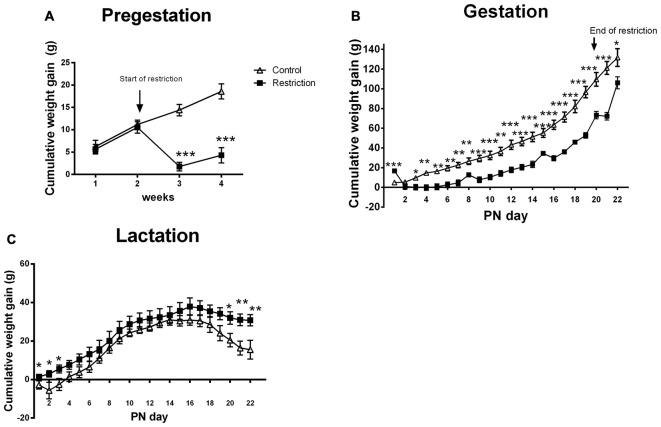
Maternal weight gain during pregestation, gestation and lactation period. Cumulative weight gain (g) of control (open triangles) and restricted dams (solid squares) during pregestation (A) gestation (B) and lactation (C). Values are expressed as means ± SEM. *p < 0.05, **p < 0.01, ***p < 0.001.